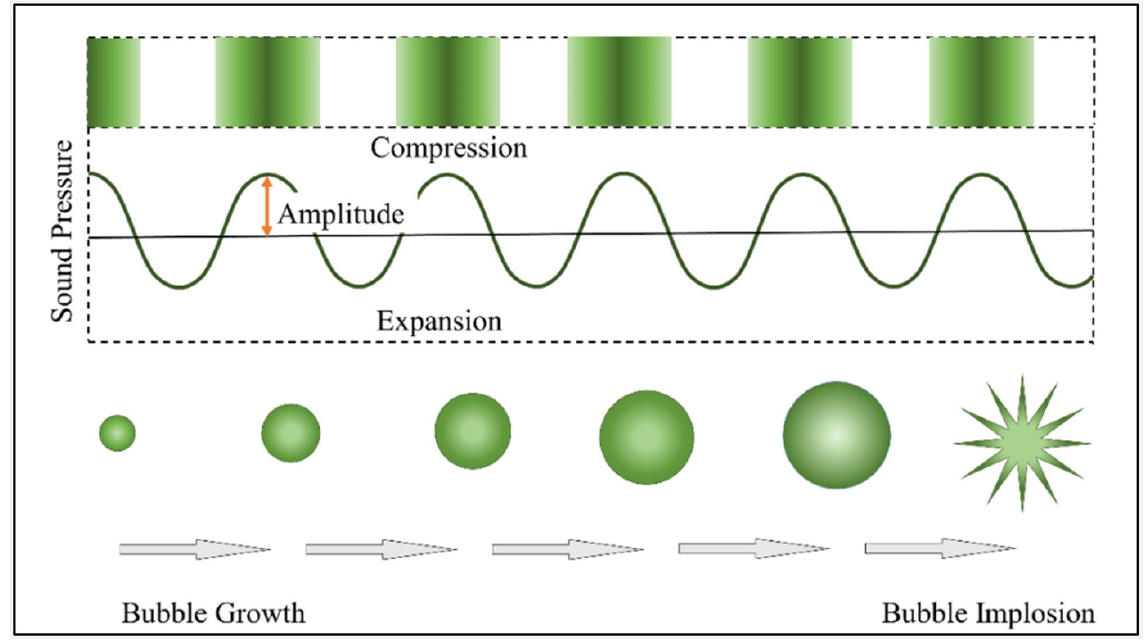
Figure 1. Illustration of the mechanism involved in ultrasonic treatment. Reproduced from Shojaeiarani et al. [40] .